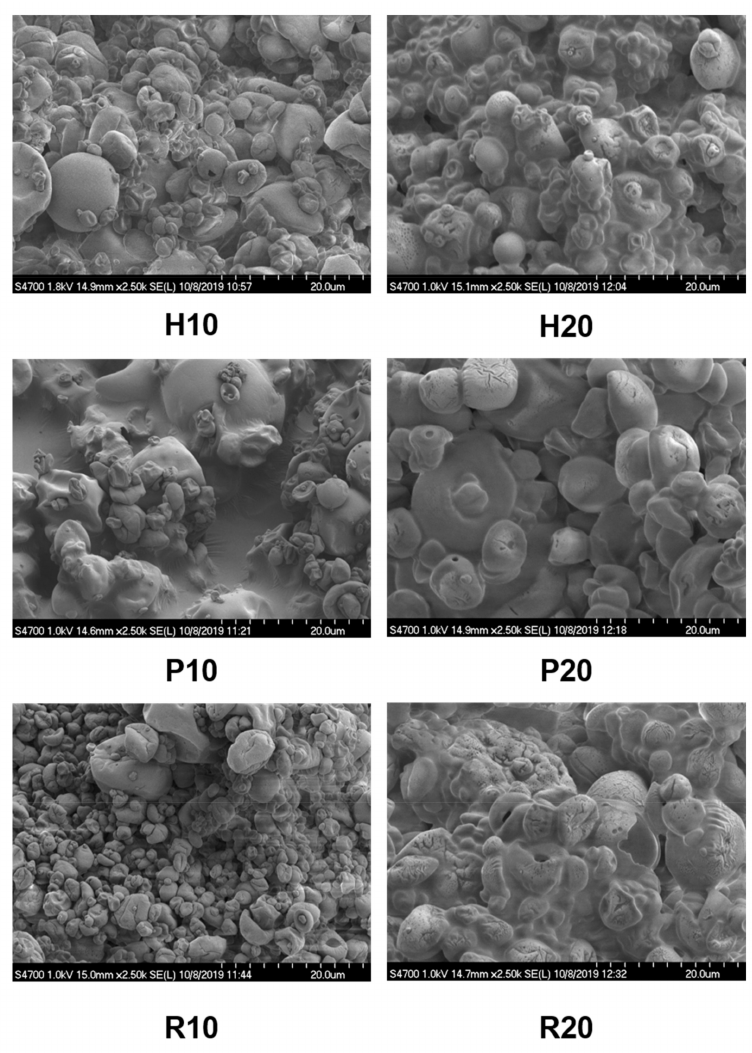
Figure 1. Protein–maltodextrin-coated hempseed oil microcapsules observed with